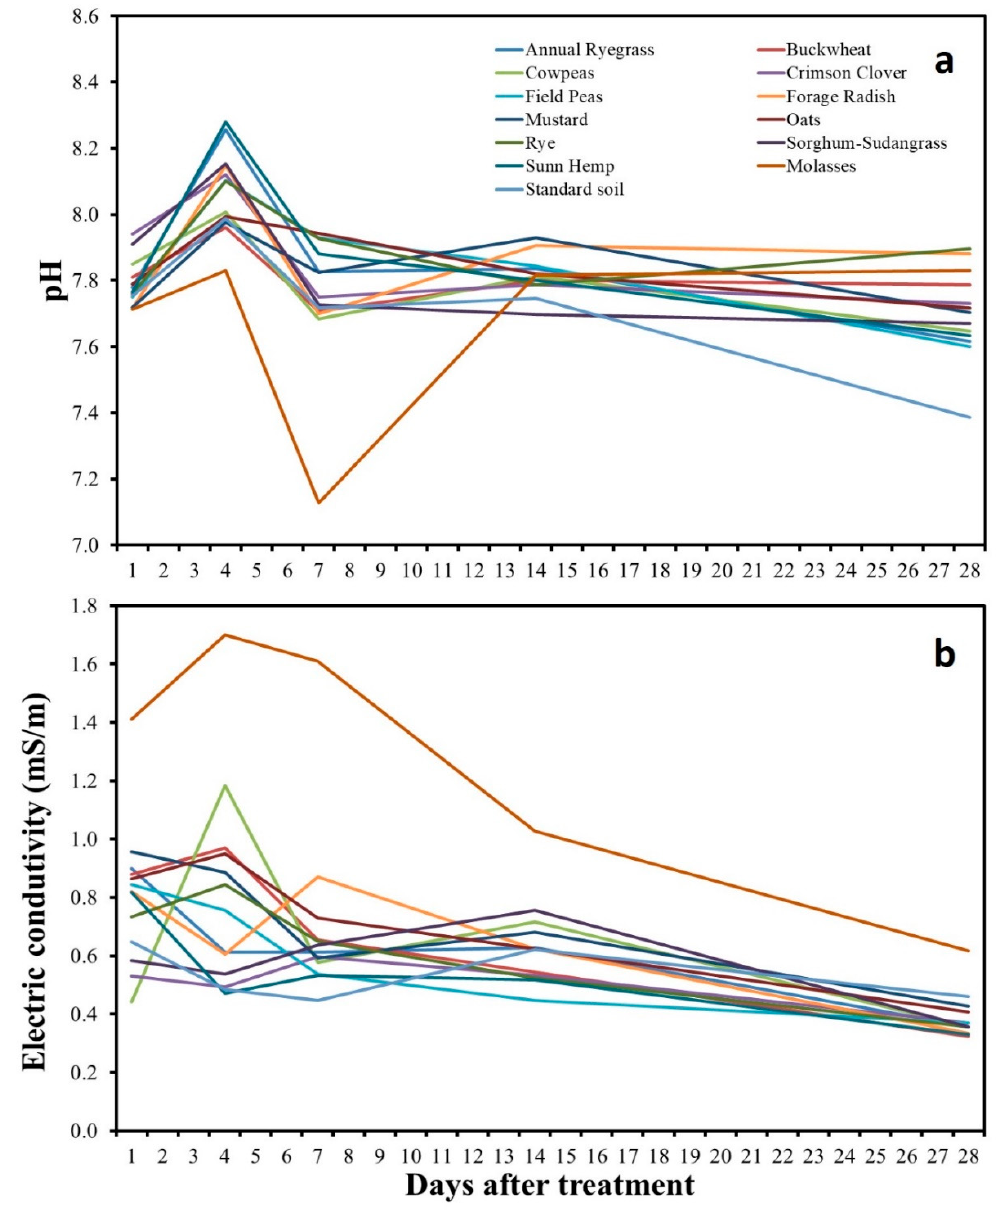
Figure 3. Soil pH and electrical conductivity (EC) time course for 28 days after treatment application.